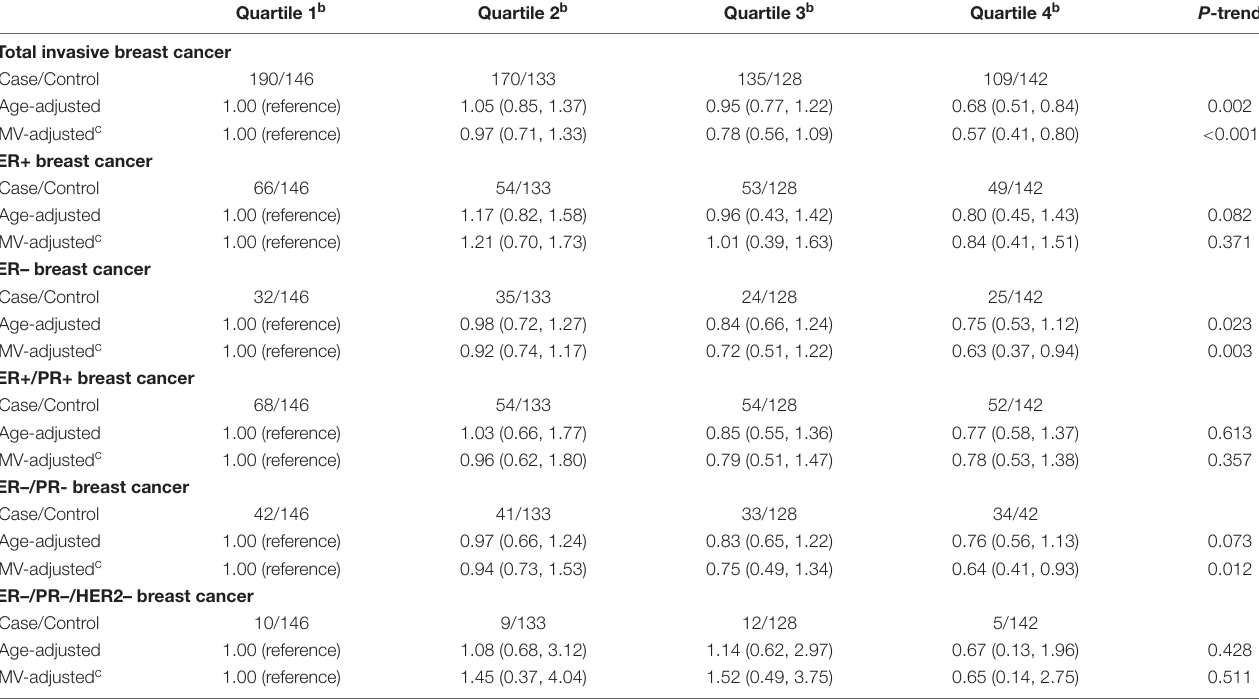
TABLE 5 | Associations (OR and 95%CIs) between the vegetable-fruit-soy diet adherence and different breast tumor molecular subtypes in postmenopausal women.